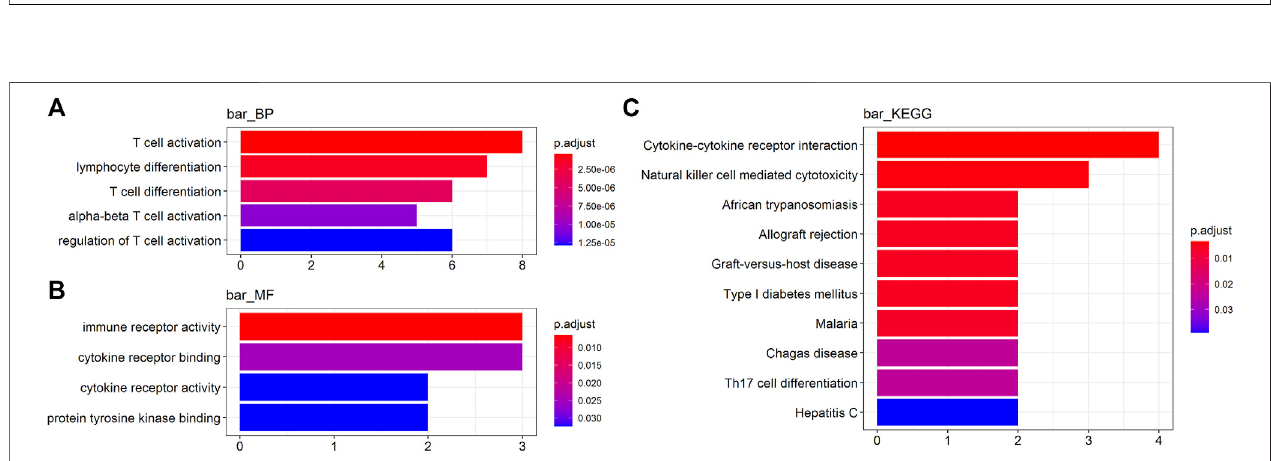
FIGURE 2 | Functional analyses of the key genes. (A, B) Gene Ontology (GO) analysis and (C) Kyoto Encyclopedia of Genes and Genomes (KEGG) analysis (BP, biological process. MF, molecular function).